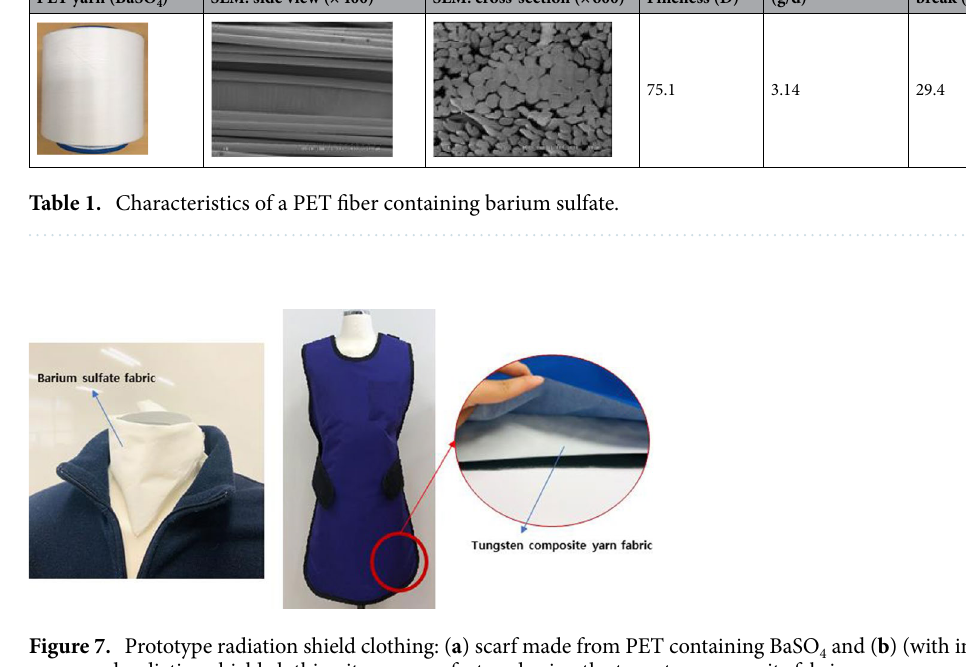
PET yarn (BaSO 4 )